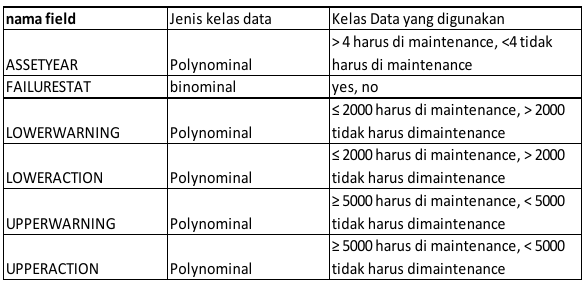
Table 8. Division of data